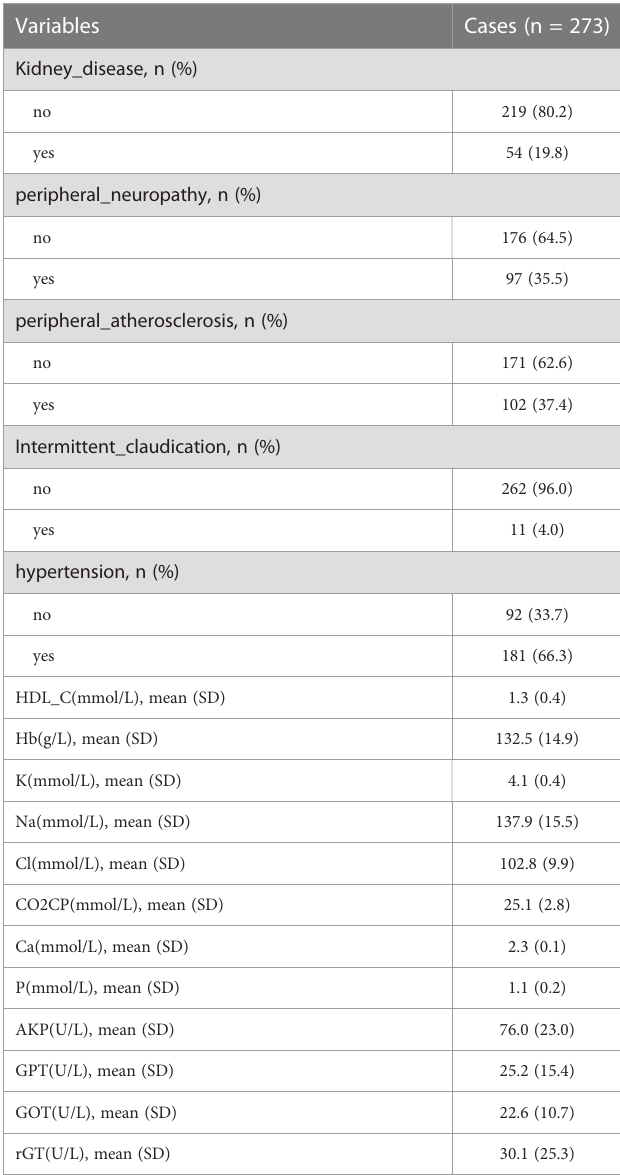
TABLE 1 Baseline characteristics